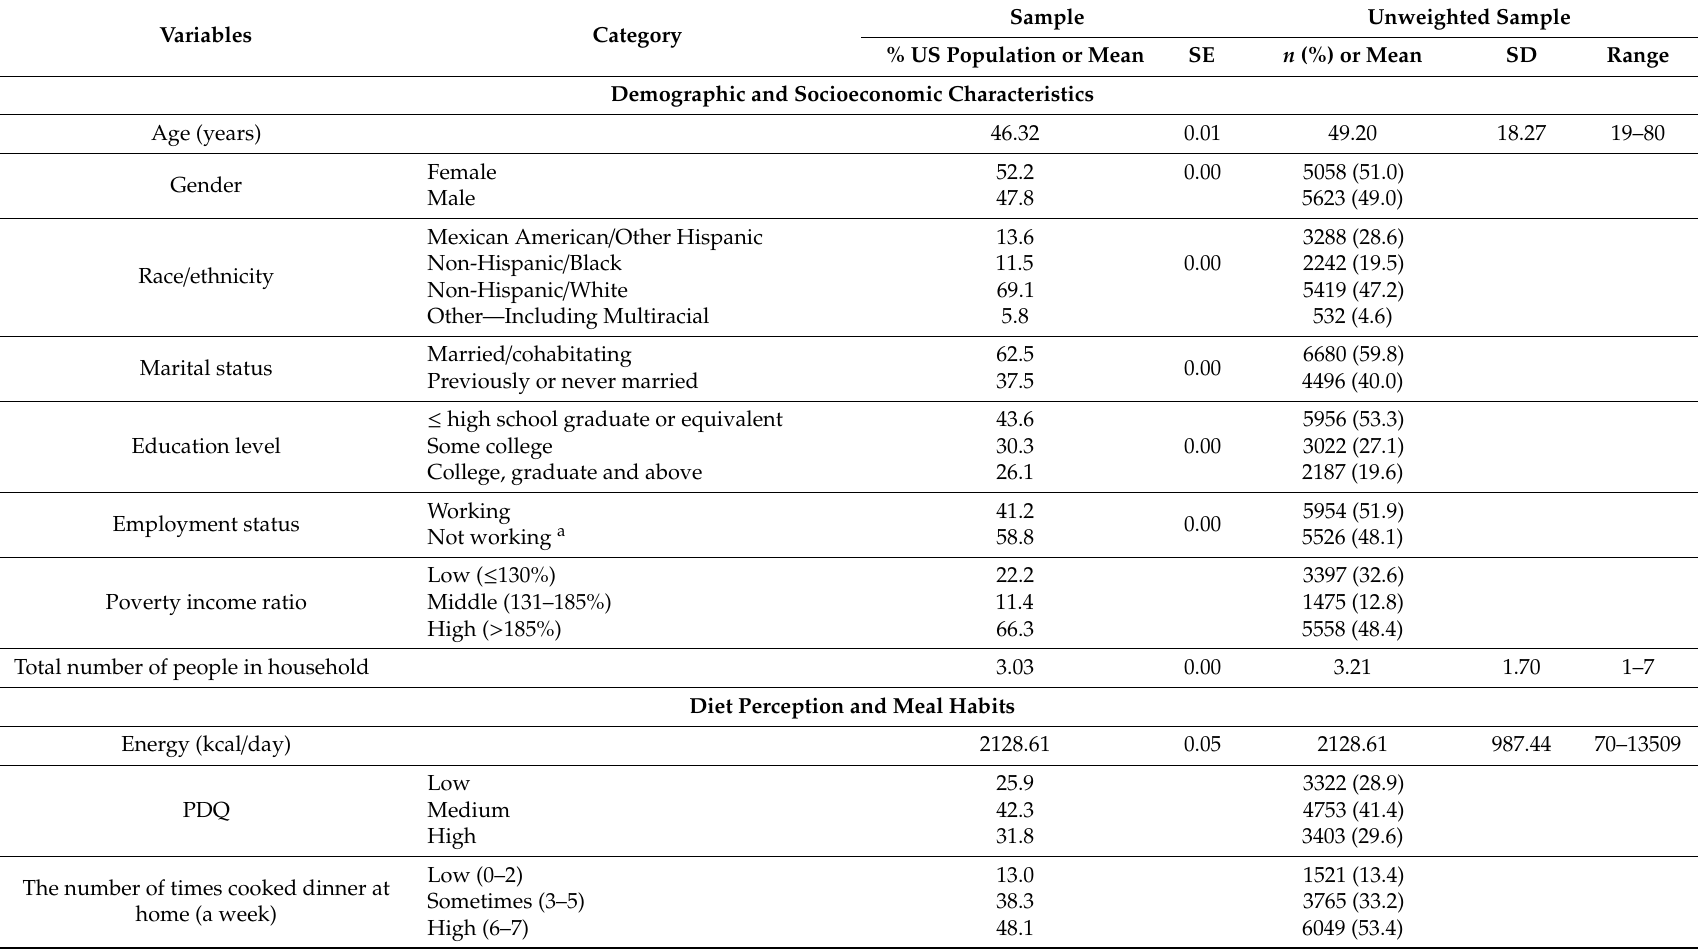
Demographic and socioeconomic characteristics and dietary habits of the NHANES 2007–2010 population (age ≥ 19 years, N = 11,481, weighted population =